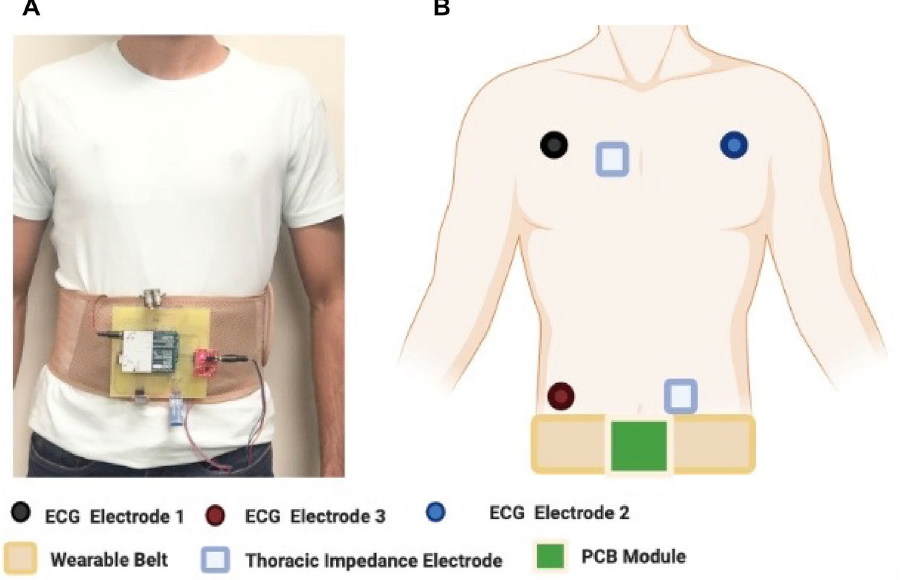
Figure 2. HWD with sensors integrated with the microcontroller ( A ). HWD module on a wearable belt for the continuous and real time monitoring of significant parameters for HF ( B ). Schematic of the HWD showing the placement of the electrodes for the ECG and thoracic